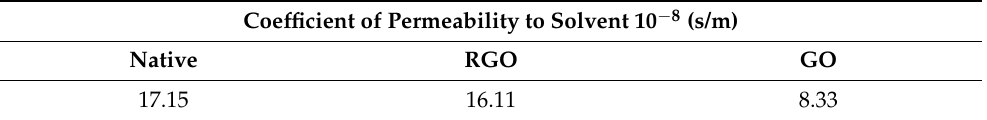
Table 2. Solvent permeability